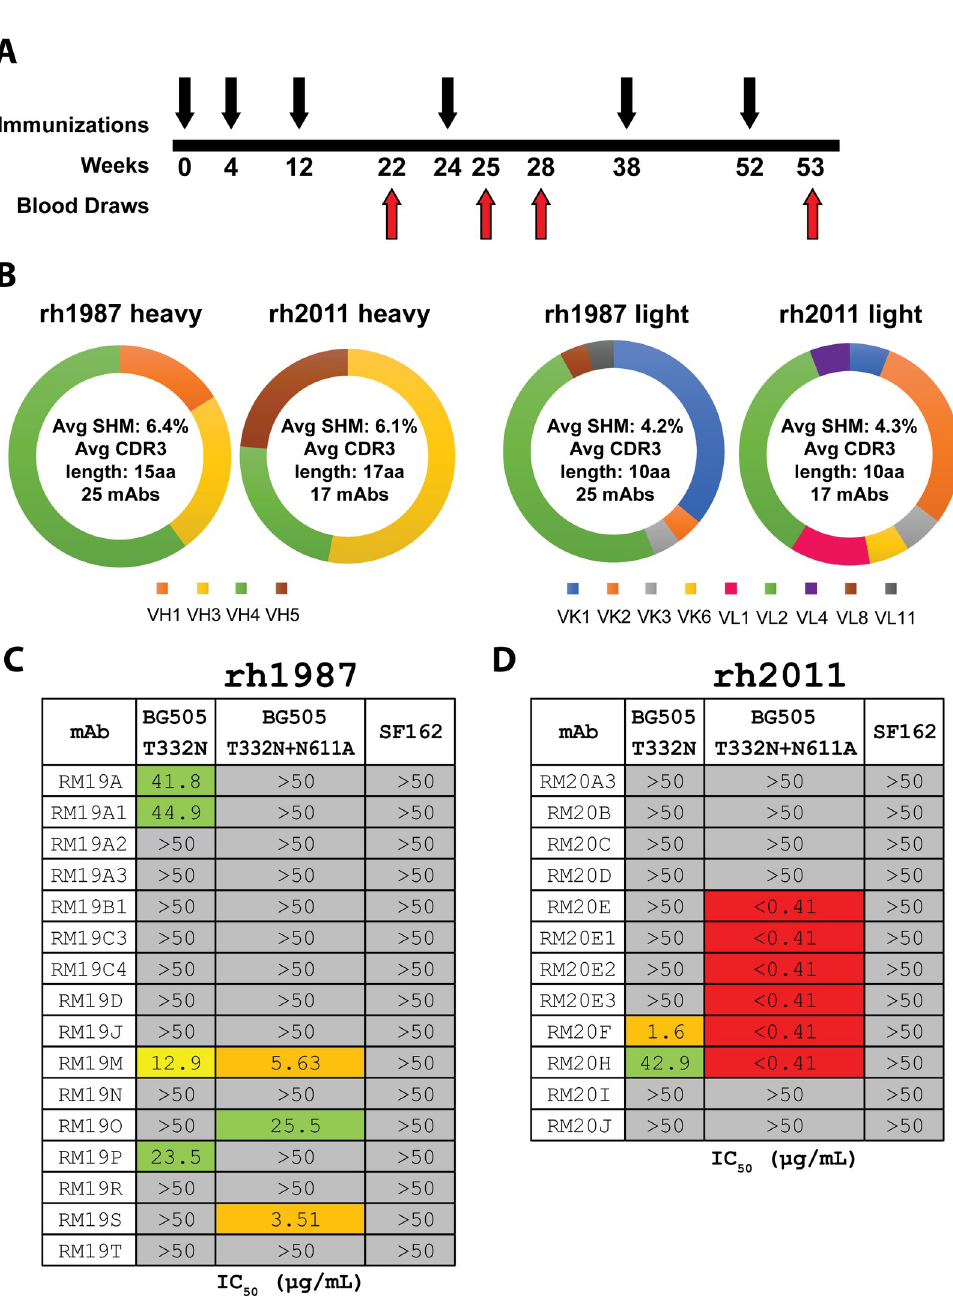
For animal rh1987, 11 KC and 14 LC mAbs were isolated. Their average heavy chain (HC) SHM (nucleotide level) was 6.4% (range: 2.1%-10.2%) with an average HC complementarity- determining region 3 (CDR-H3) length of 15 amino acids (aa) (range: 7–23) (S2 Table). The